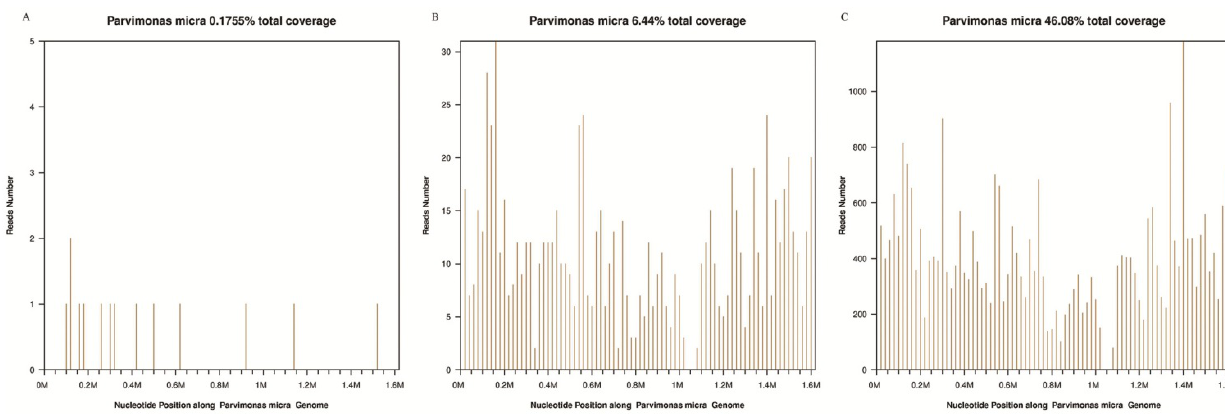
Figure 5. The aligned unique reads yielded from preoperative synovial fluid (A), intraoperative synovial fluid (B) and sonicate fluid (C) covered 0.18%, 6.44% and 46.08% of the Pavimonas micra reference genome, respectively. Y-axis was reads number. x-axis was genome length. The bar was reads number per 1kb in the